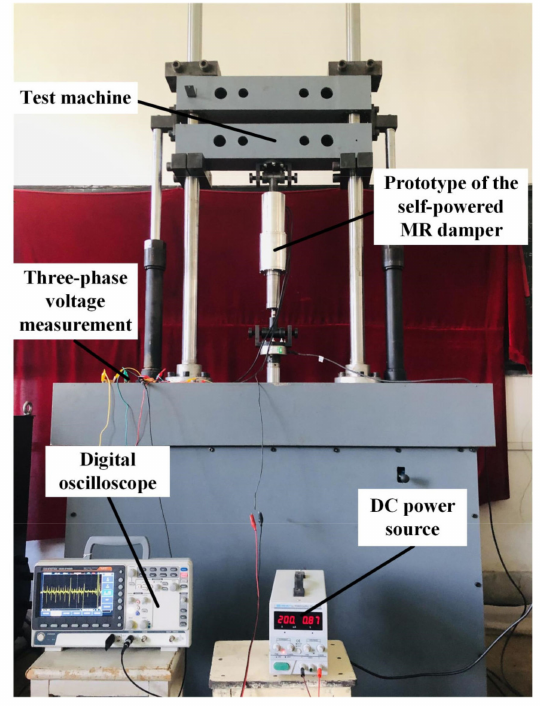
Figure 14. Bench test of self-powered MR